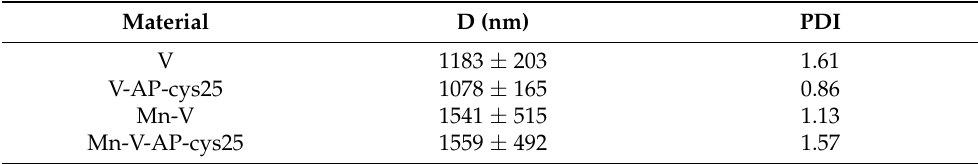
Table 3. Hydrodynamic particle size and polydispersity